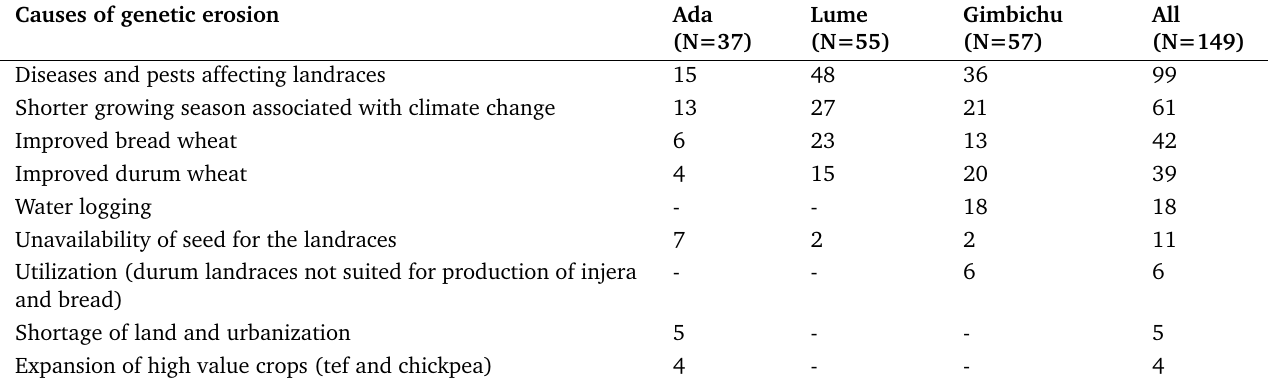
Table 3. Reasons for not growing local durum wheat landraces in 2018 in Ada, Lume, and Gimbichu districts, provided by farmers during the Group